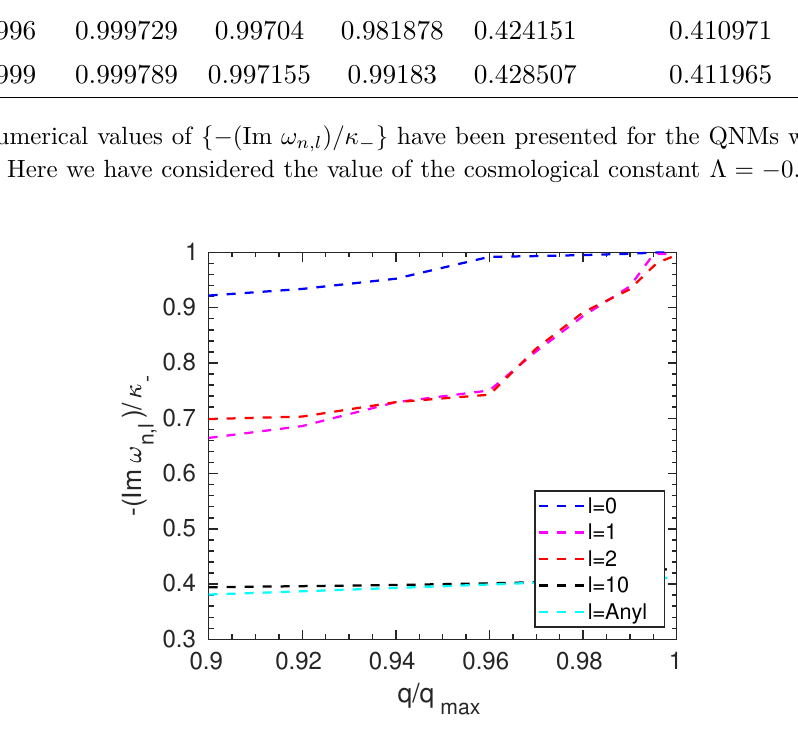
Figure 6 . We have plotted {− ( Im ω n,l ) /κ − } against ( q/q max ) , where we have taken the value of cosmological constant Λ = − 0 . 06 and mass M = 1 , for different choices of ‘